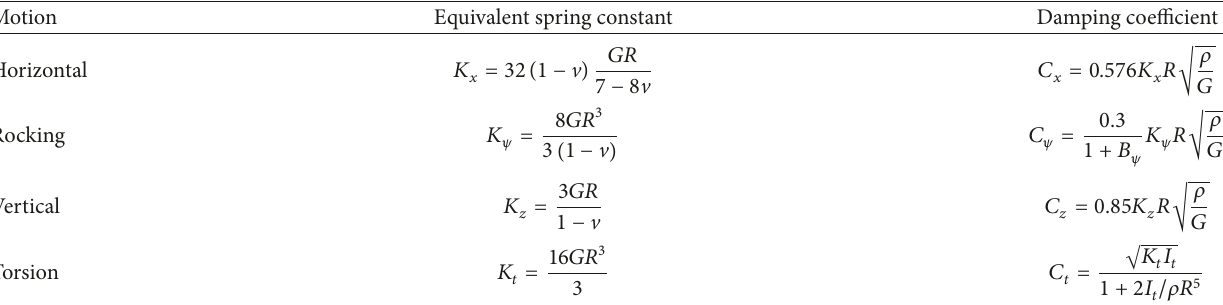
Table 3: Soil impedance functions recommended in ASCE code [24].